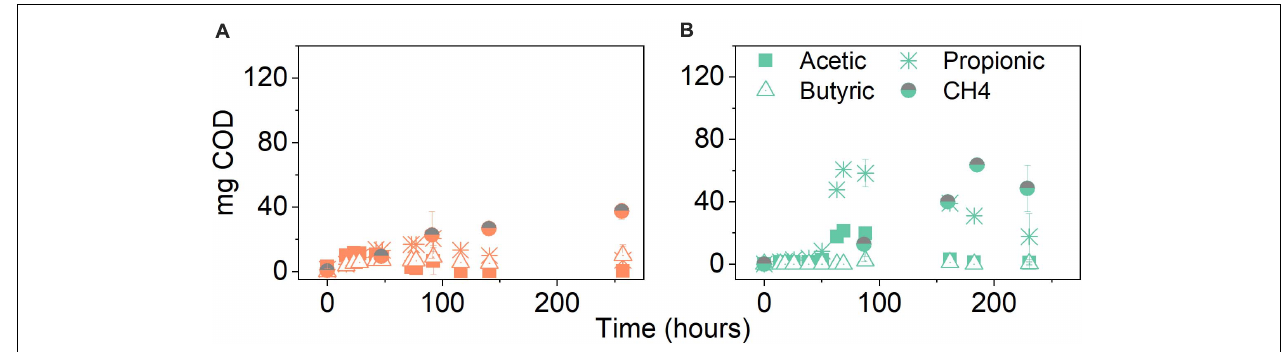
FIGURE 5 | Volatile fatty acid and CH 4 production (mg COD) over time for (A) glucose and (B) glycerol conversion experiments at elevated pCO 2 using evolved inoculum at 5 bar initial pCO 2 . Pressure corresponds to initial values before equilibrium. Data points represent experimental data. Bars represent the standard deviation of three biological replicates measured at the beginning, middle, and end of the